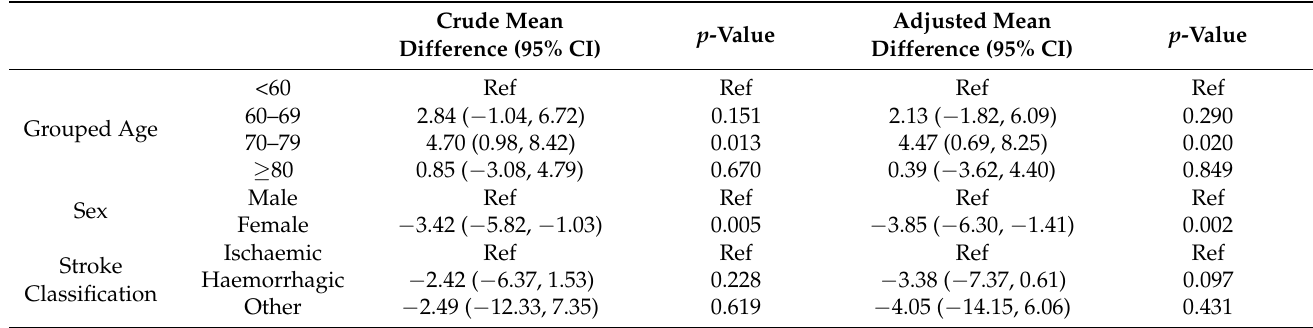
Table 3. Clinical characteristics associated with the PROM total